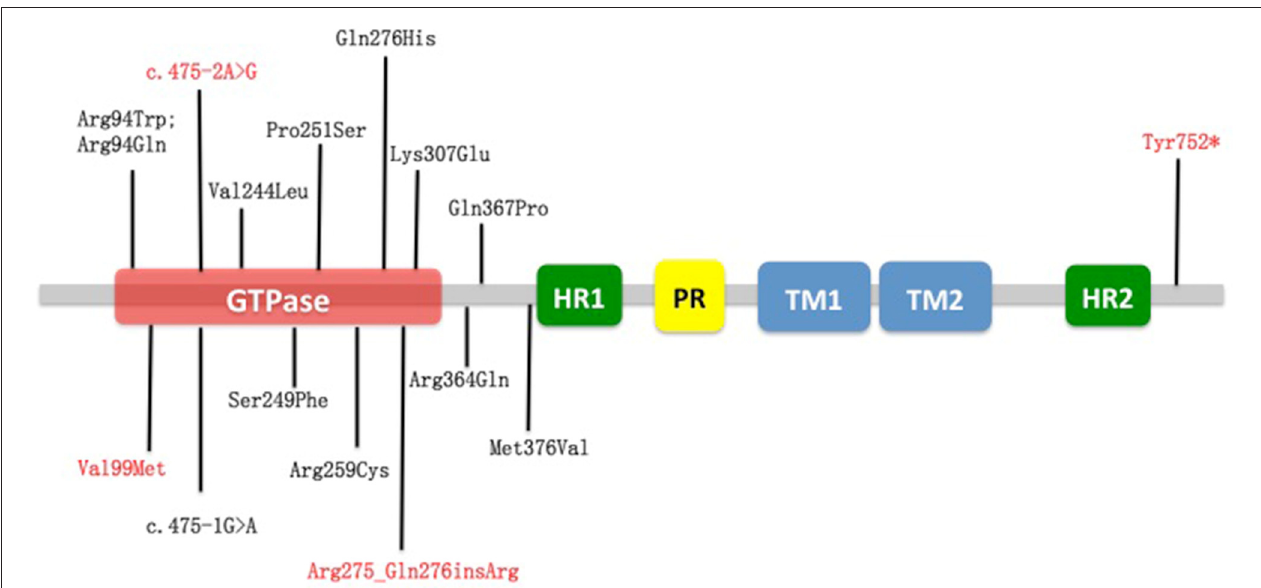
FIGURE 1 | Schematic representation of MFN2 and localization of variants reported in this study. In red are novel variants on MFN2 detected in this study. In black are variants already reported. Nearly all variants were around the large GTPase domain near the N-terminus. GTPase, guanosine triphosphatase; HR1, heptad repeat 1; HR2, heptad repeat 2; PR, proline-rich; TM1, transmembrane domain 1; TM2, transmembrane domain